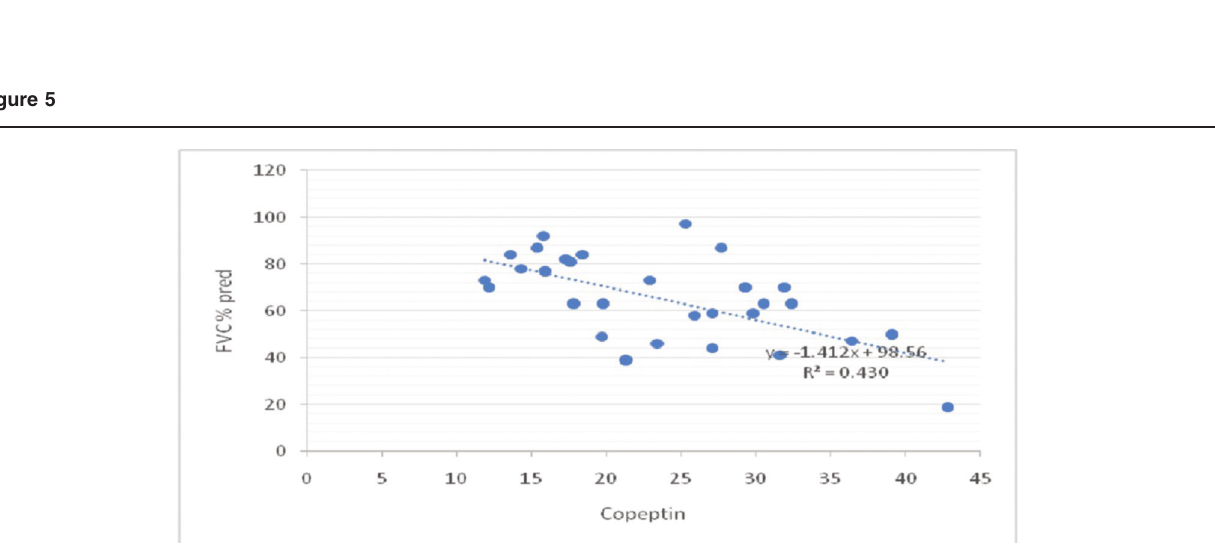
Correlation between copeptin and FVC% predicted among group of cases. FVC, forced vital